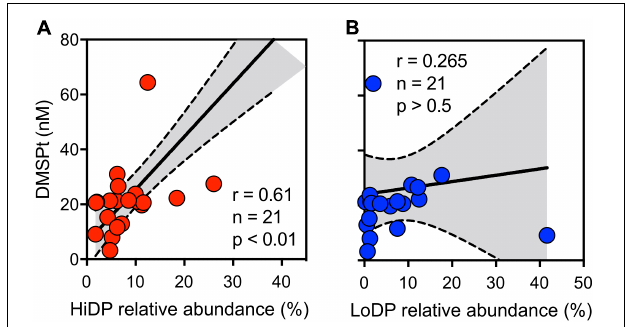
FIGURE 2 | Concentration total DMSP (DMSPt), with the relative abundance of sequences putatively annotated as (A) high-DMSP-producing (red) and (B) low-DMSP-producing phytoplankton (blue) at Port Hacking NRS between February 2017 and January 2019. Pearson’s r indicates a significant correlation between